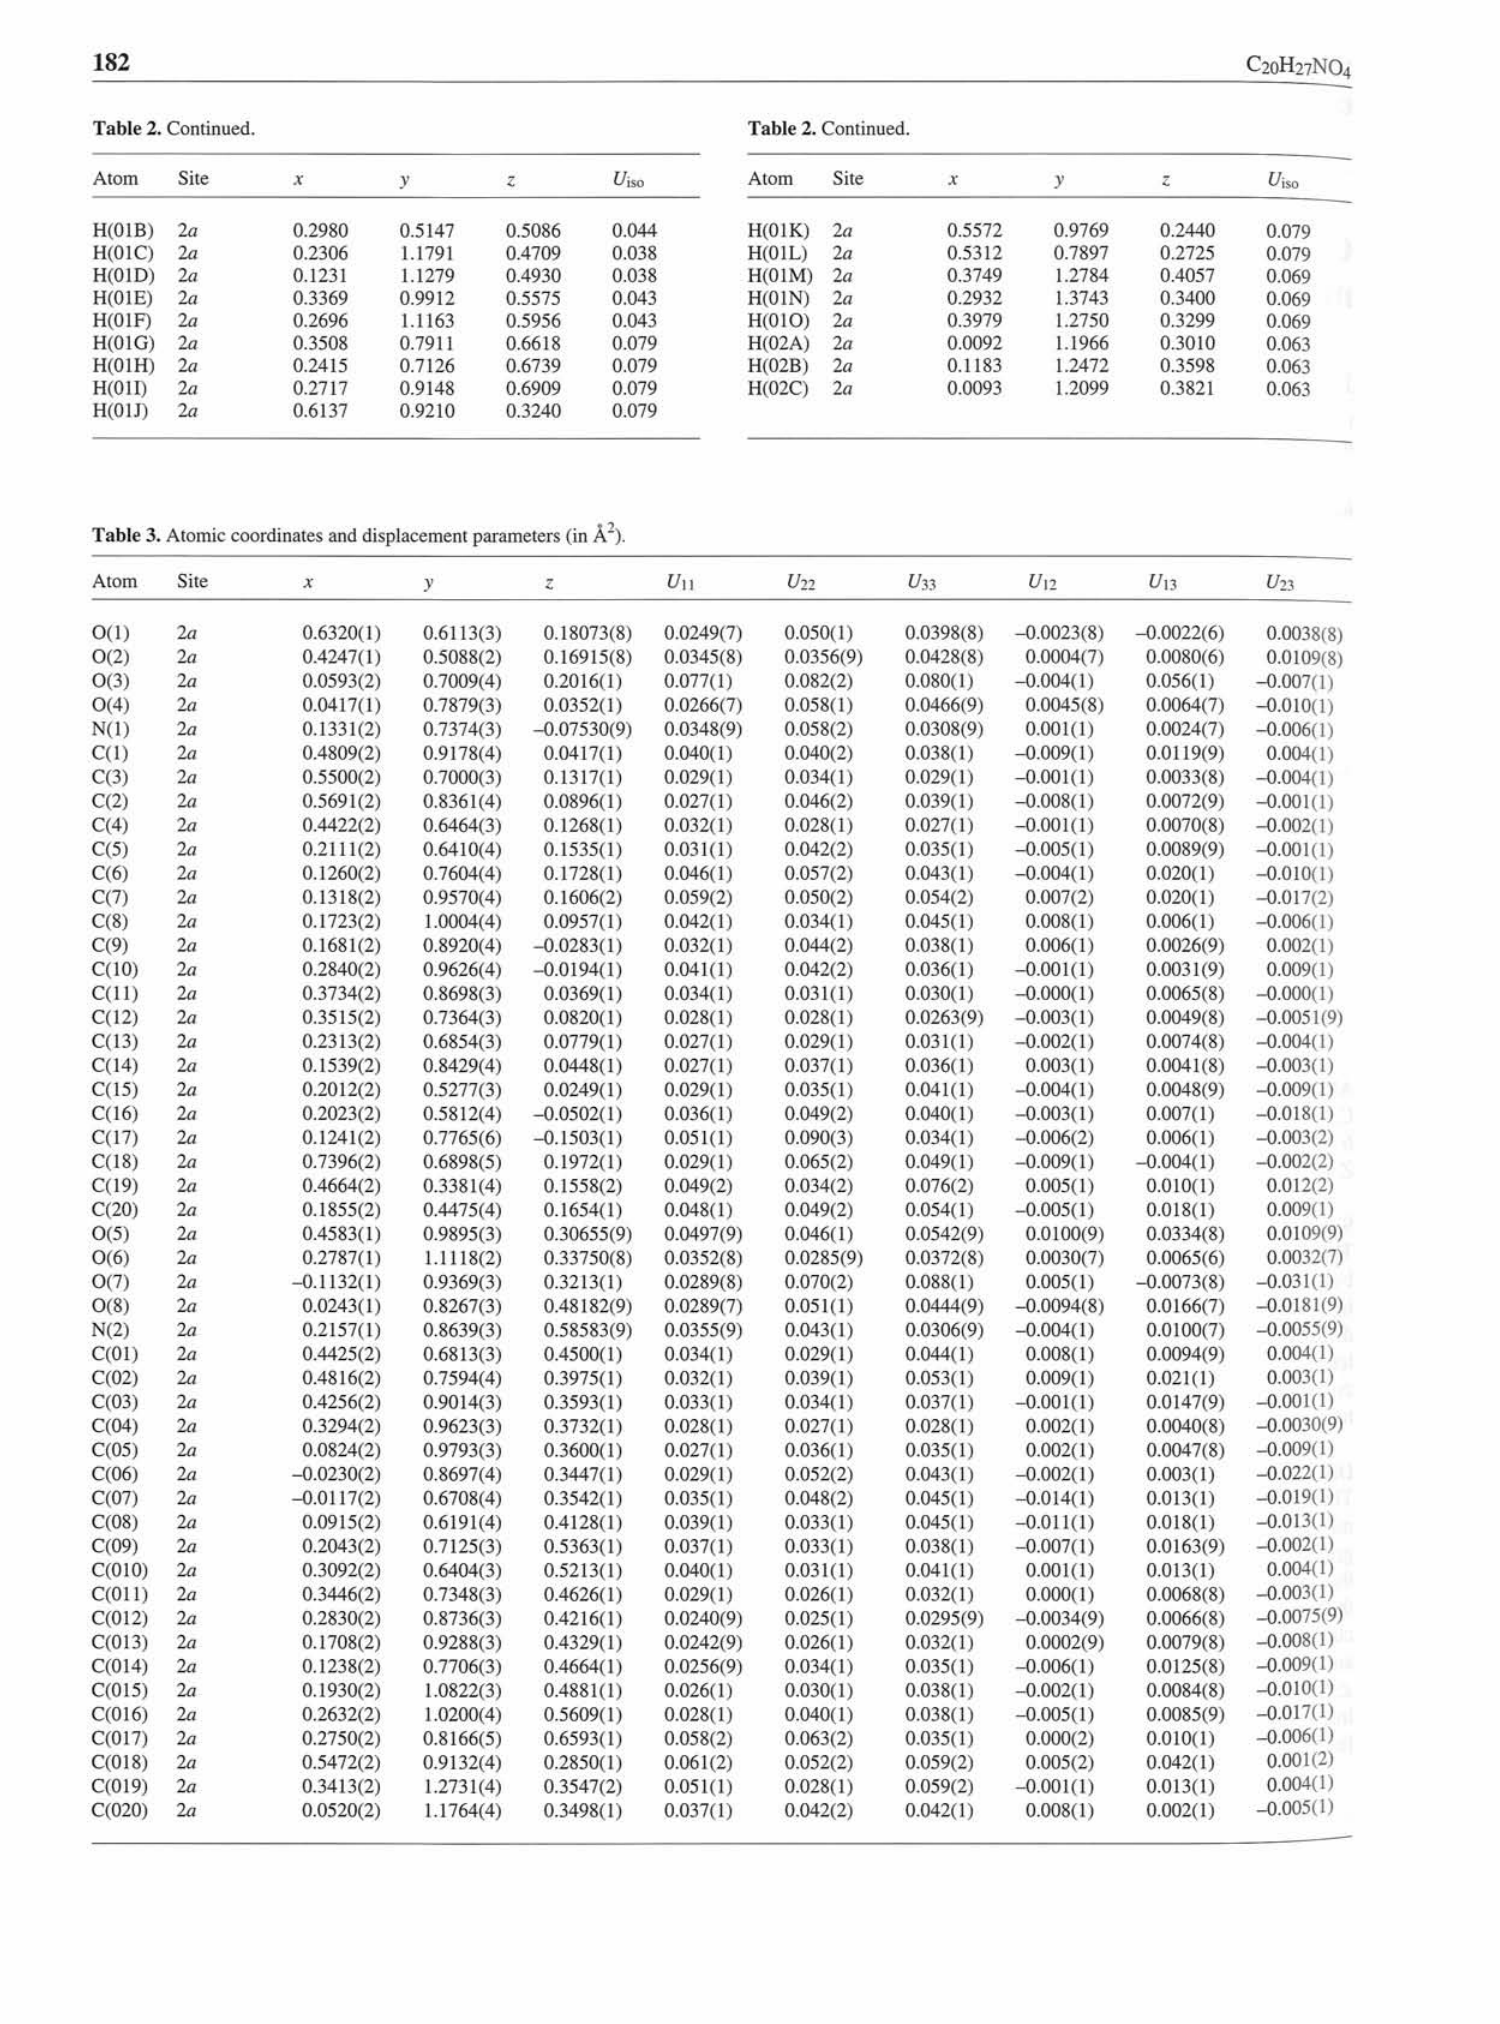
Table 3. Atomic coordinates and displacement parameters (in